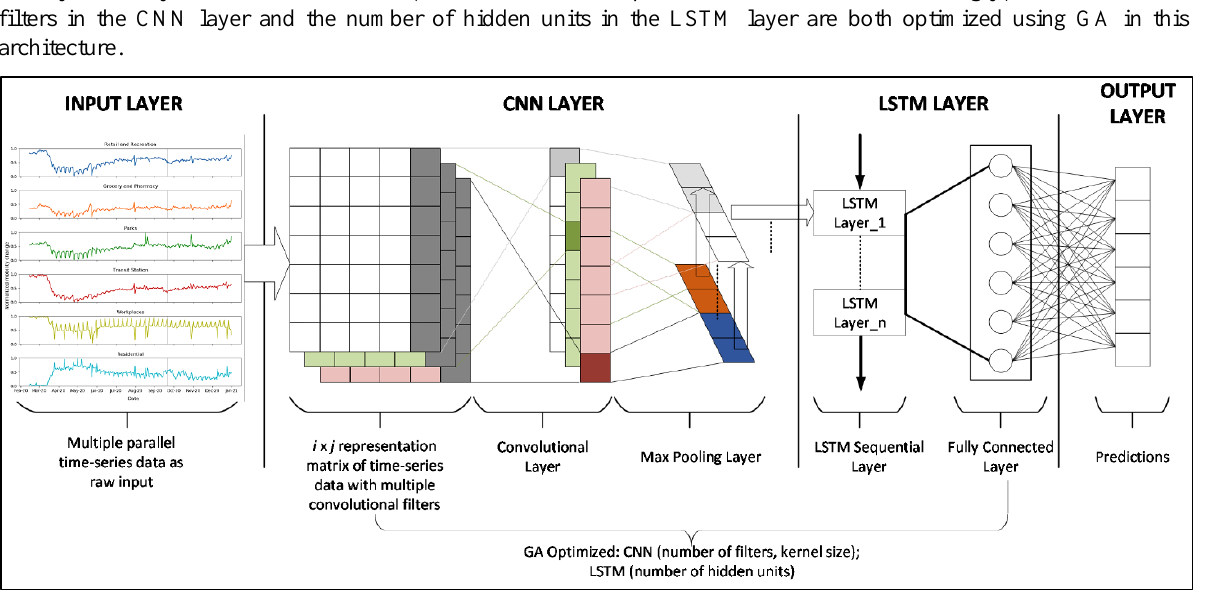
Figure 5. Structure of proposed GA-Optimized Multivariate CNN-LSTM (GA CNN-LSTM) for prediction of multi-channel mobility data that origins from six different area of